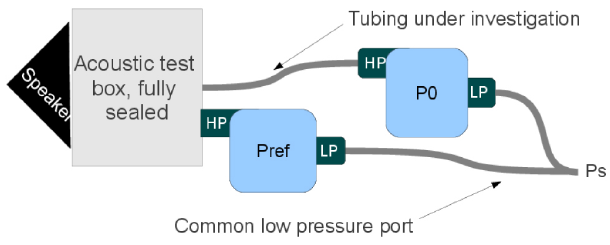
Fig. 12. Schematic drawing of the experiment to measure the tub- ing response. While the HP port of the reference transducer (Pref) is directly connected to the acoustic box, the HP port of the pressure measurement under investigation ( P 0) is connected with the neces- sary tubing of the real system. Ps is the common ambient pressure on the LP port of the